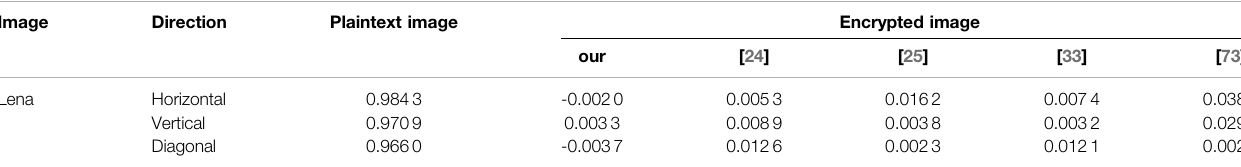
TABLE 5 | Comparison of correlation coef fi cient with other literature Image